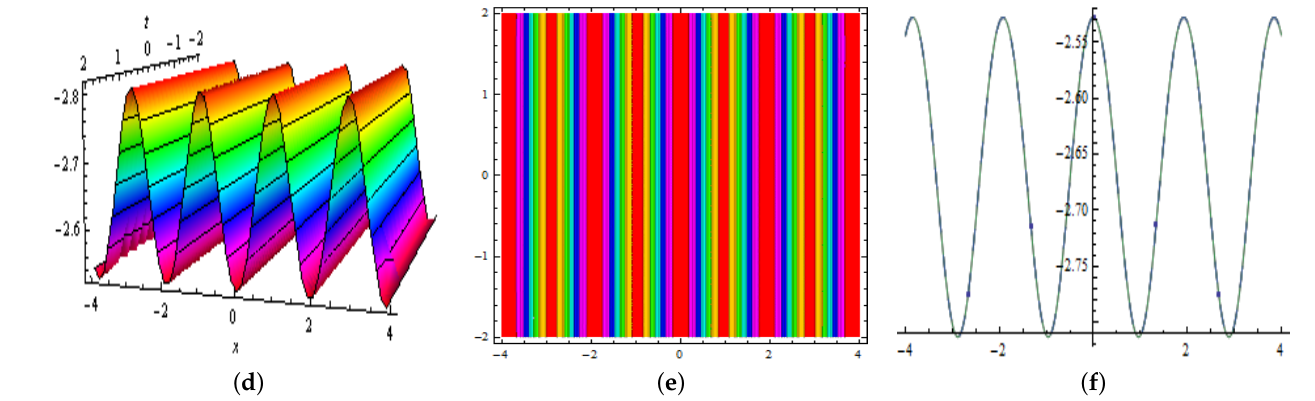
Figure 17. Represented three-dimensions in ( a ); contour in ( b ) and two-dimensions in ( c ), Graphical representation of n 64 ( x , t ) in Equation (62), for b 2 = − 5, b 3 = 1, b 6 = 5, z 1 = 1, z 2 = 3, z 3 = − 0.5, α = 0.9,